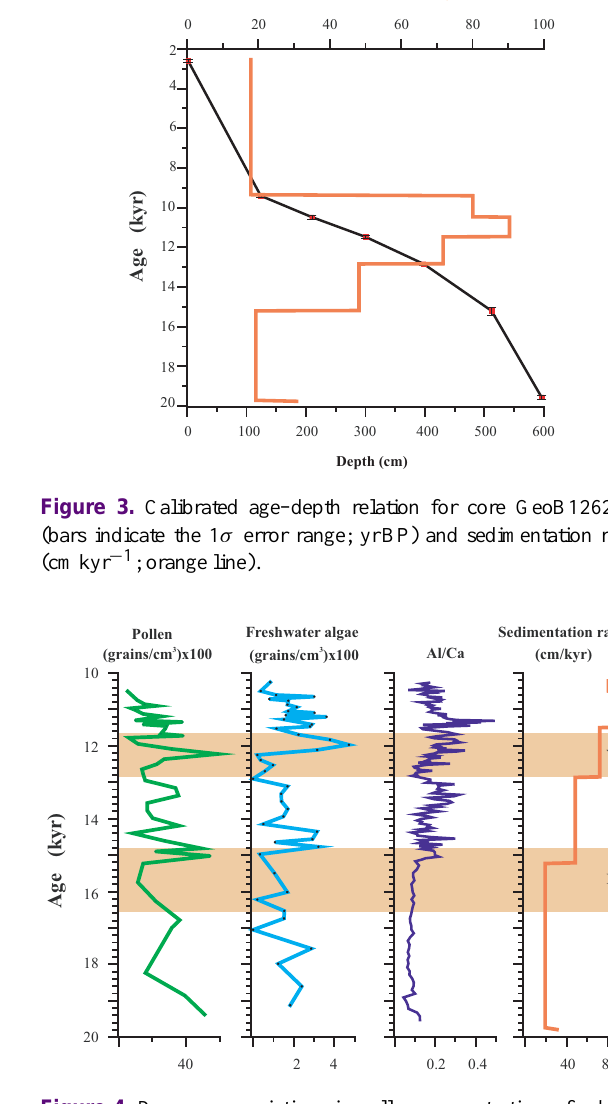
Figure 4. Downcore variations in pollen concentrations, freshwa- ter algae concentrations, Al / Ca ratios and sedimentation rate esti- mates during the interval 19–10kyrBP. Shading indicates time in- tervals of Heinrich event 1 (H1) and the Younger Dryas